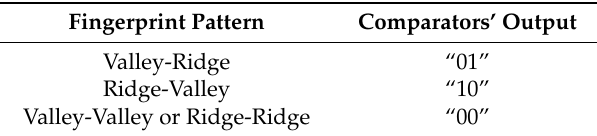
Figure 4. Proposed algorithm to detect the fingerprint features and produce the final image result for further image processing. Table 2. The output of the comparators for possible fingerprint patterns.